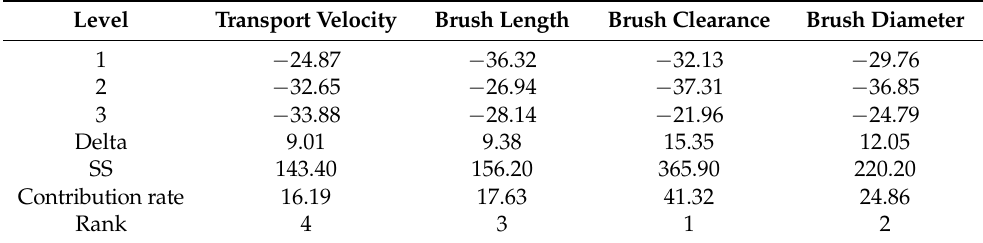
Table 8. Response table for damage S/N ratios of jujube-shaped cherry